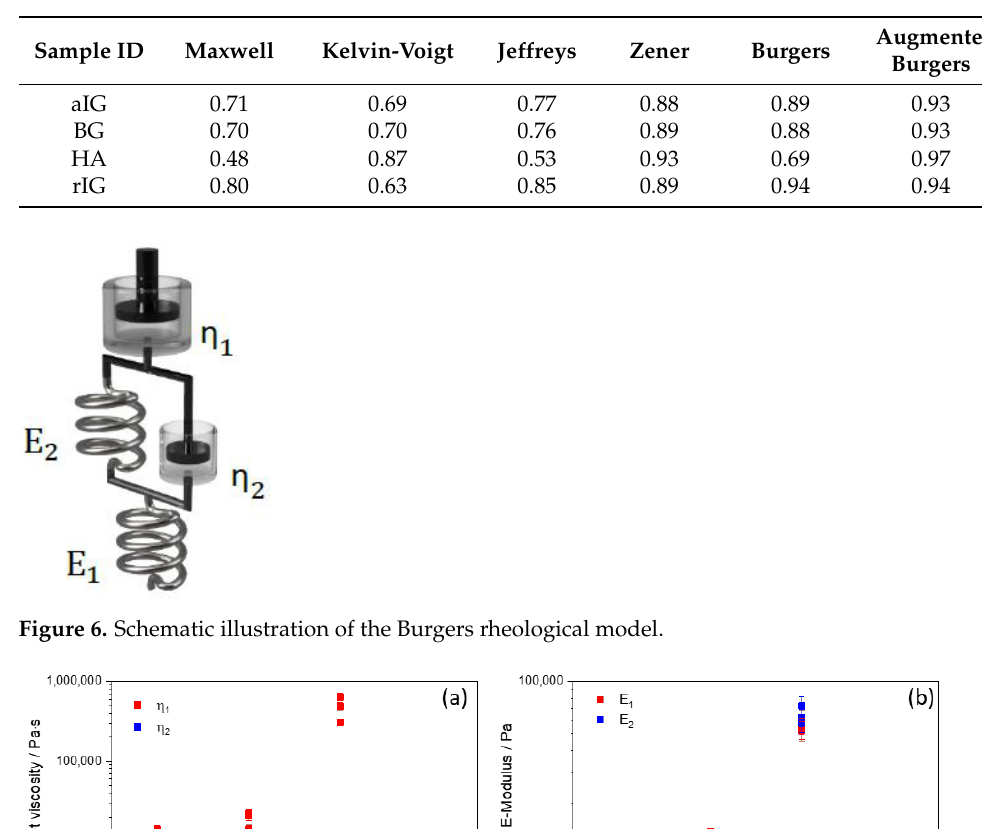
Table 4. Resulting adjusted R 2 for commonly used rheological models.